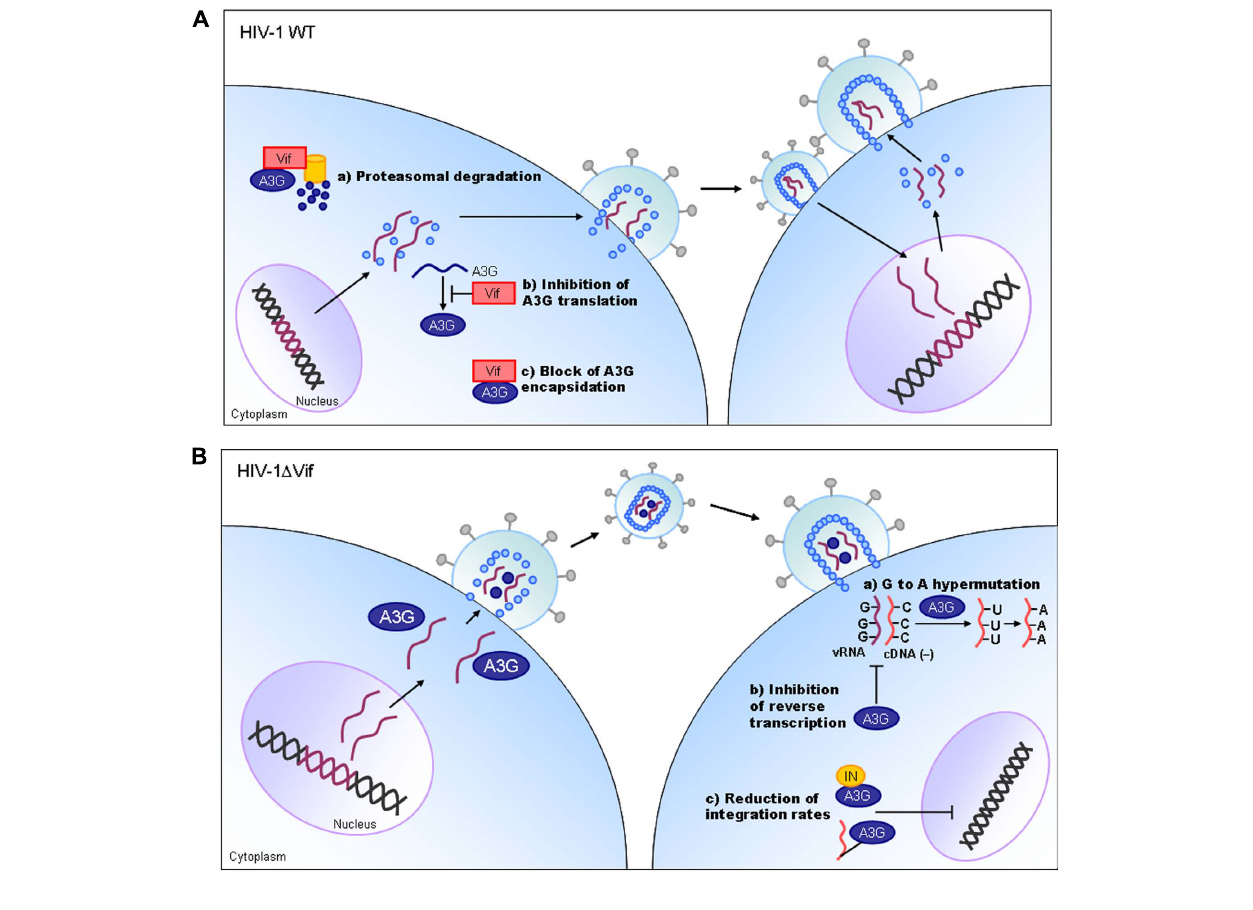
FIGURE 3 | HIV-1 replication andAPOBEC3G. On the basis of results reported so far, the action mechanism ofVif is depicted. Replication process for wild-type (WT) and Δ Vif mutant viruses are schematically shown